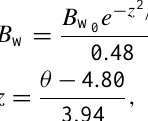
Fig. 5. Magnetic wave amplitude derived from electric field energy density from the Galileo spacecraft from Menietti et al. (2008) and an equatorial value of B w as shown at L = 10. In red, a Gaussian fit to that